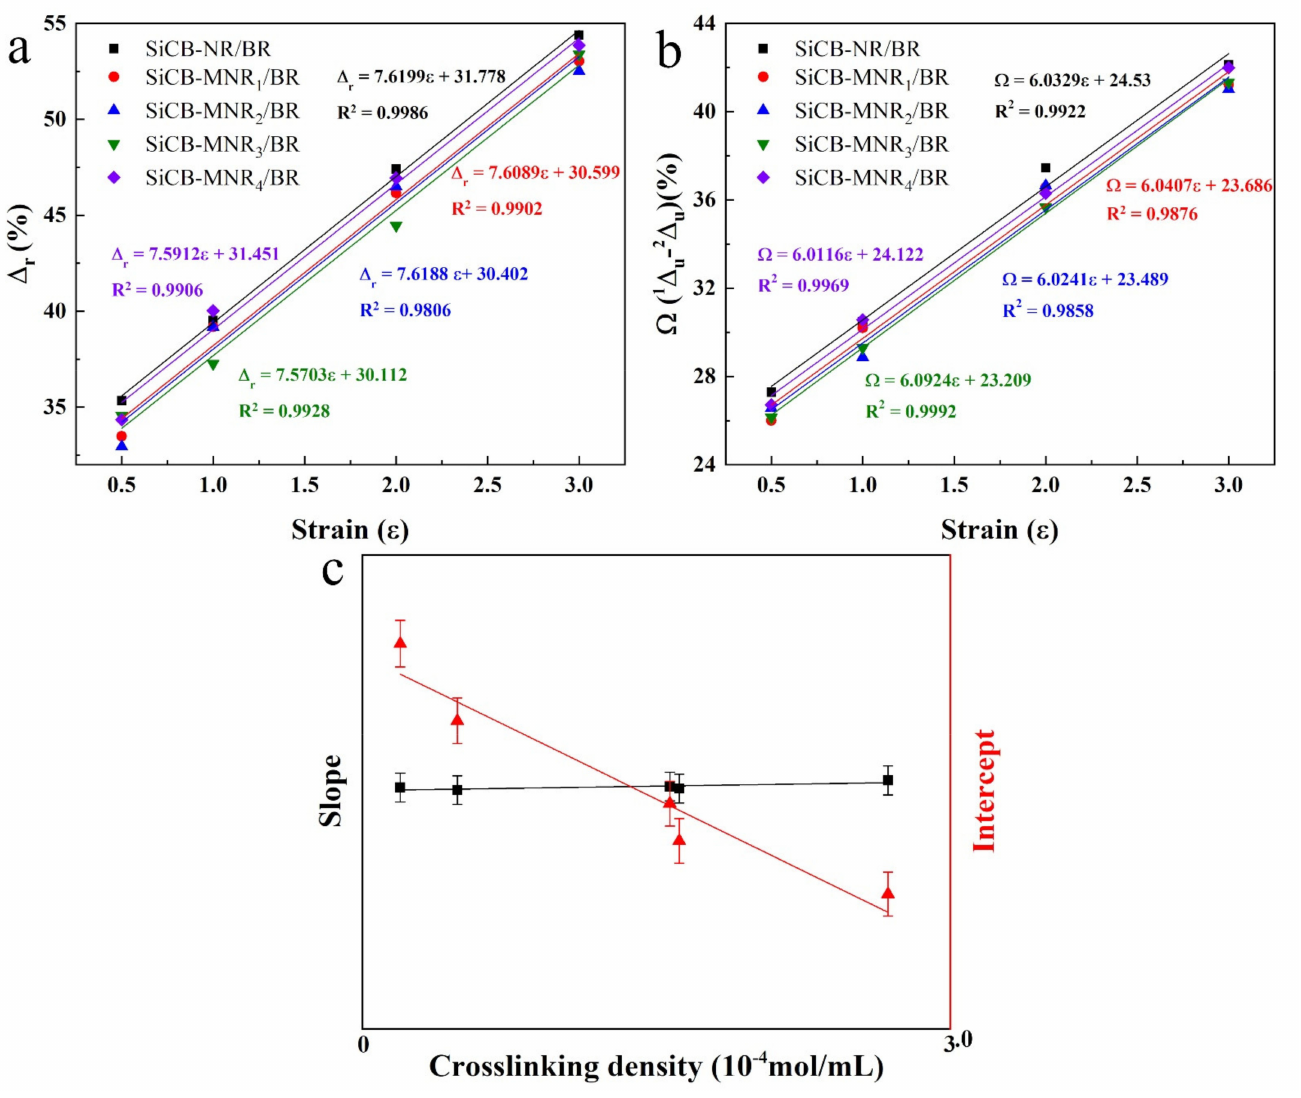
Figure 7. ( a ) The dissipation factor ( ∆ r ), ( b ) the difference of dissipation factor ( Ω ) as a function of ε m for SiCB-MNRx/BR composites with different crosslinking densities, and ( c ) schematic for the effect of crosslinking degree of polymers on Mullins